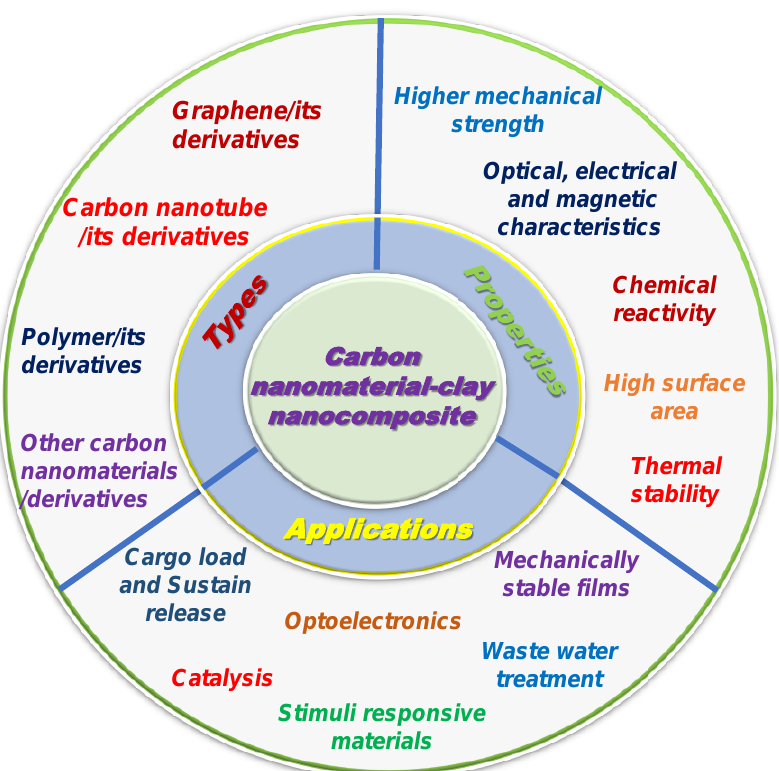
Figure 2. Schematic view of carbon nanomaterial–clay nanocomposites, along with their types, properties, and applications.